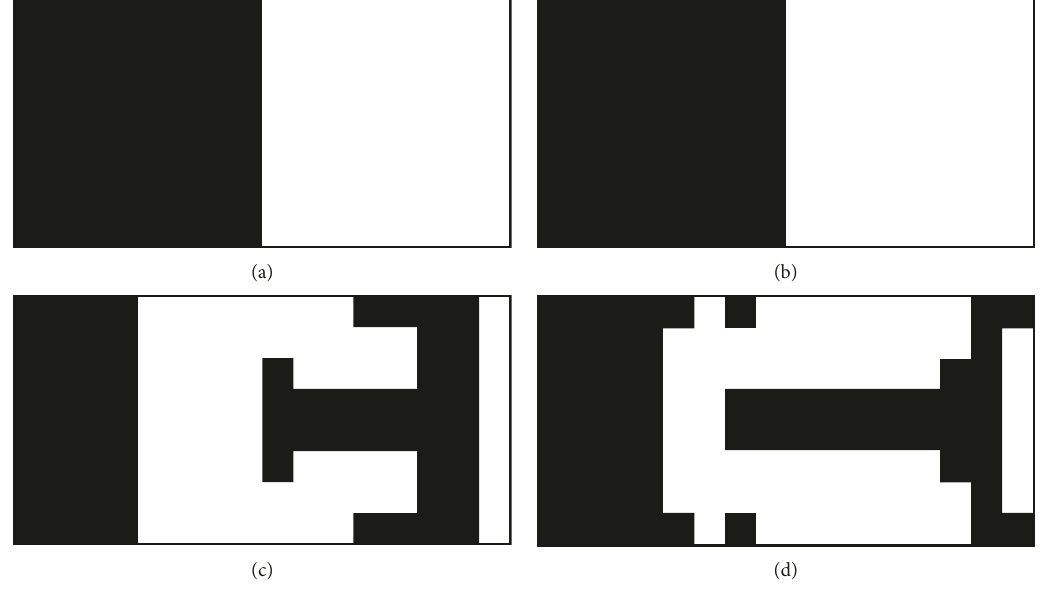
Figure 6: The optimal layouts of CLD treatment. (a) f the initial values of the design variables 0.75. (c) f and the initial values of the design variables 0.75.